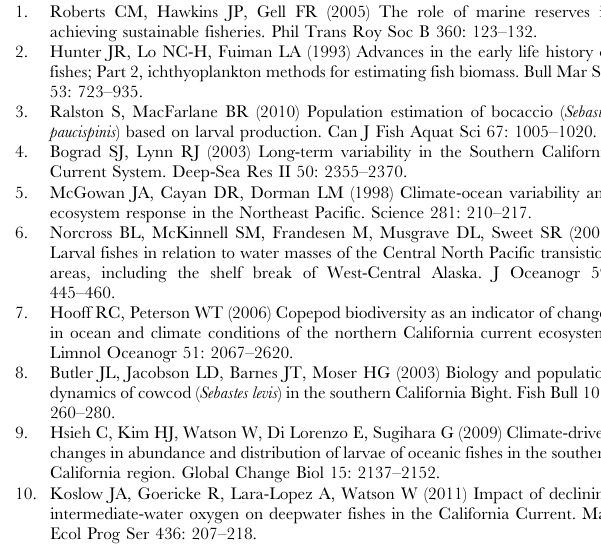
Figure S4 Hellinger-transformed values of benthic taxa in the CCA from 2002–2004. (A–C) Sebastes spp.; (D–F) Sebastes